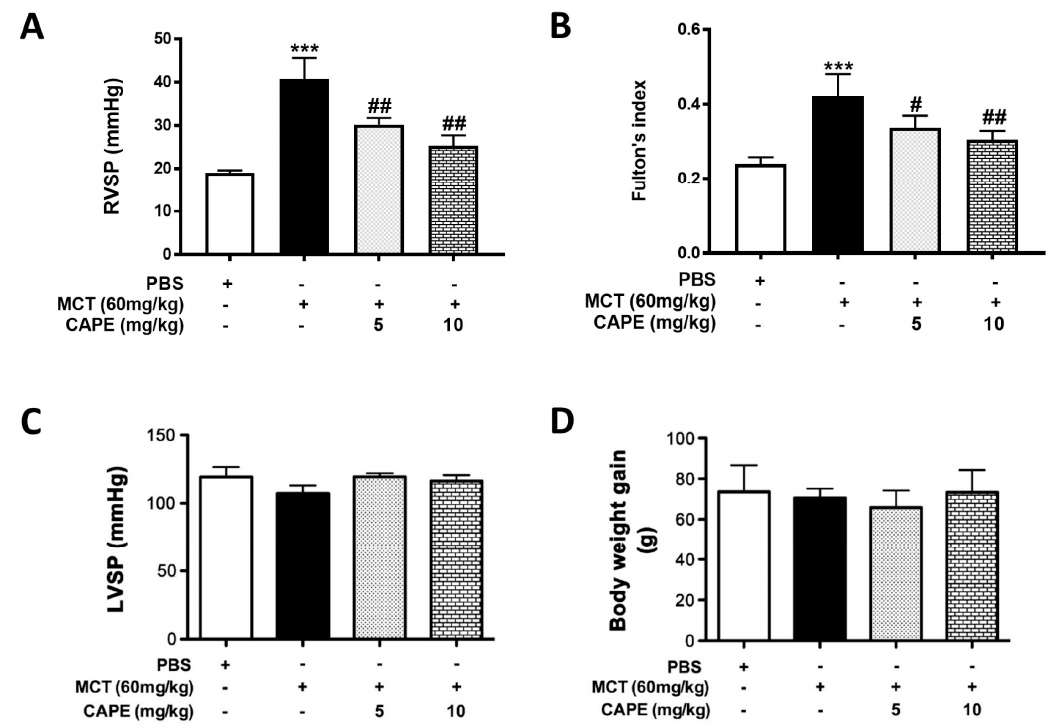
Figure 1. Caffeic acid phenethyl ester (CAPE) improves monocrotaline (MCT)-induced pulmonary arterial hypertension (PAH) in rats. ( A ) Rats were treated with CAPE ( n = 6, 5 or 10 mg/kg) from day 14 to 28 after MCT injection (60 mg/kg). The rats in the healthy group received PBS injection instead of MCT ( n = 5). Assessment of right ventricular systolic pressure (RVSP), ( B ) right ventricular hypertrophy (Fulton index, the ratio of right ventricular weight to left ventricular plus septal weight, ( C ) left ventricular systolic pressure (LVSP), and ( D ) body weight in rats. Data in A and B are expressed as mean ± SEM of five independent experiments. *** p < 0.01, as compared with the PBS group. # p < 0.05; ## p < 0.01, as compared with the rats exposed to MCT alone.